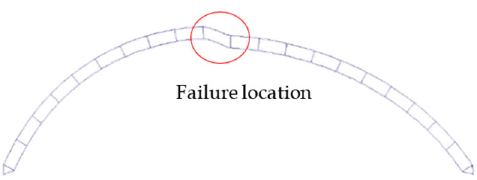
Figure 33. Global deformation and failure mode at point A during chord local failure under HSUVL.